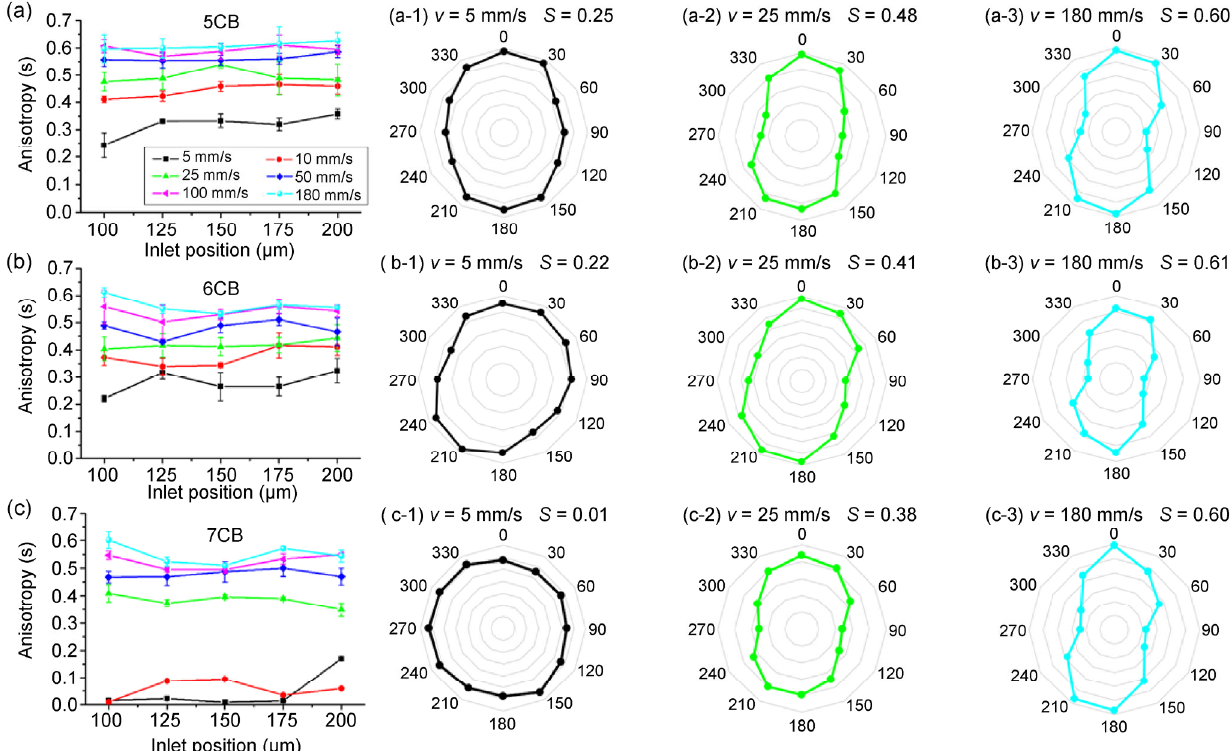
Fig. 28 Molecular orientation in a nano gap measured by Gao and Ma et al.[140]. (a) Anisotropy for 5CB molecules in the inlet region, (a-1) to (a-3) represent the relative value of Raman intensity at different θ recorder at position (0, 100) under speed of 5 mm/s, 25 m/s and 180 mm/s. (b) and (c) for 6CB and 7CB, respectively [140]. Copyright 2016, Springer Science+Business